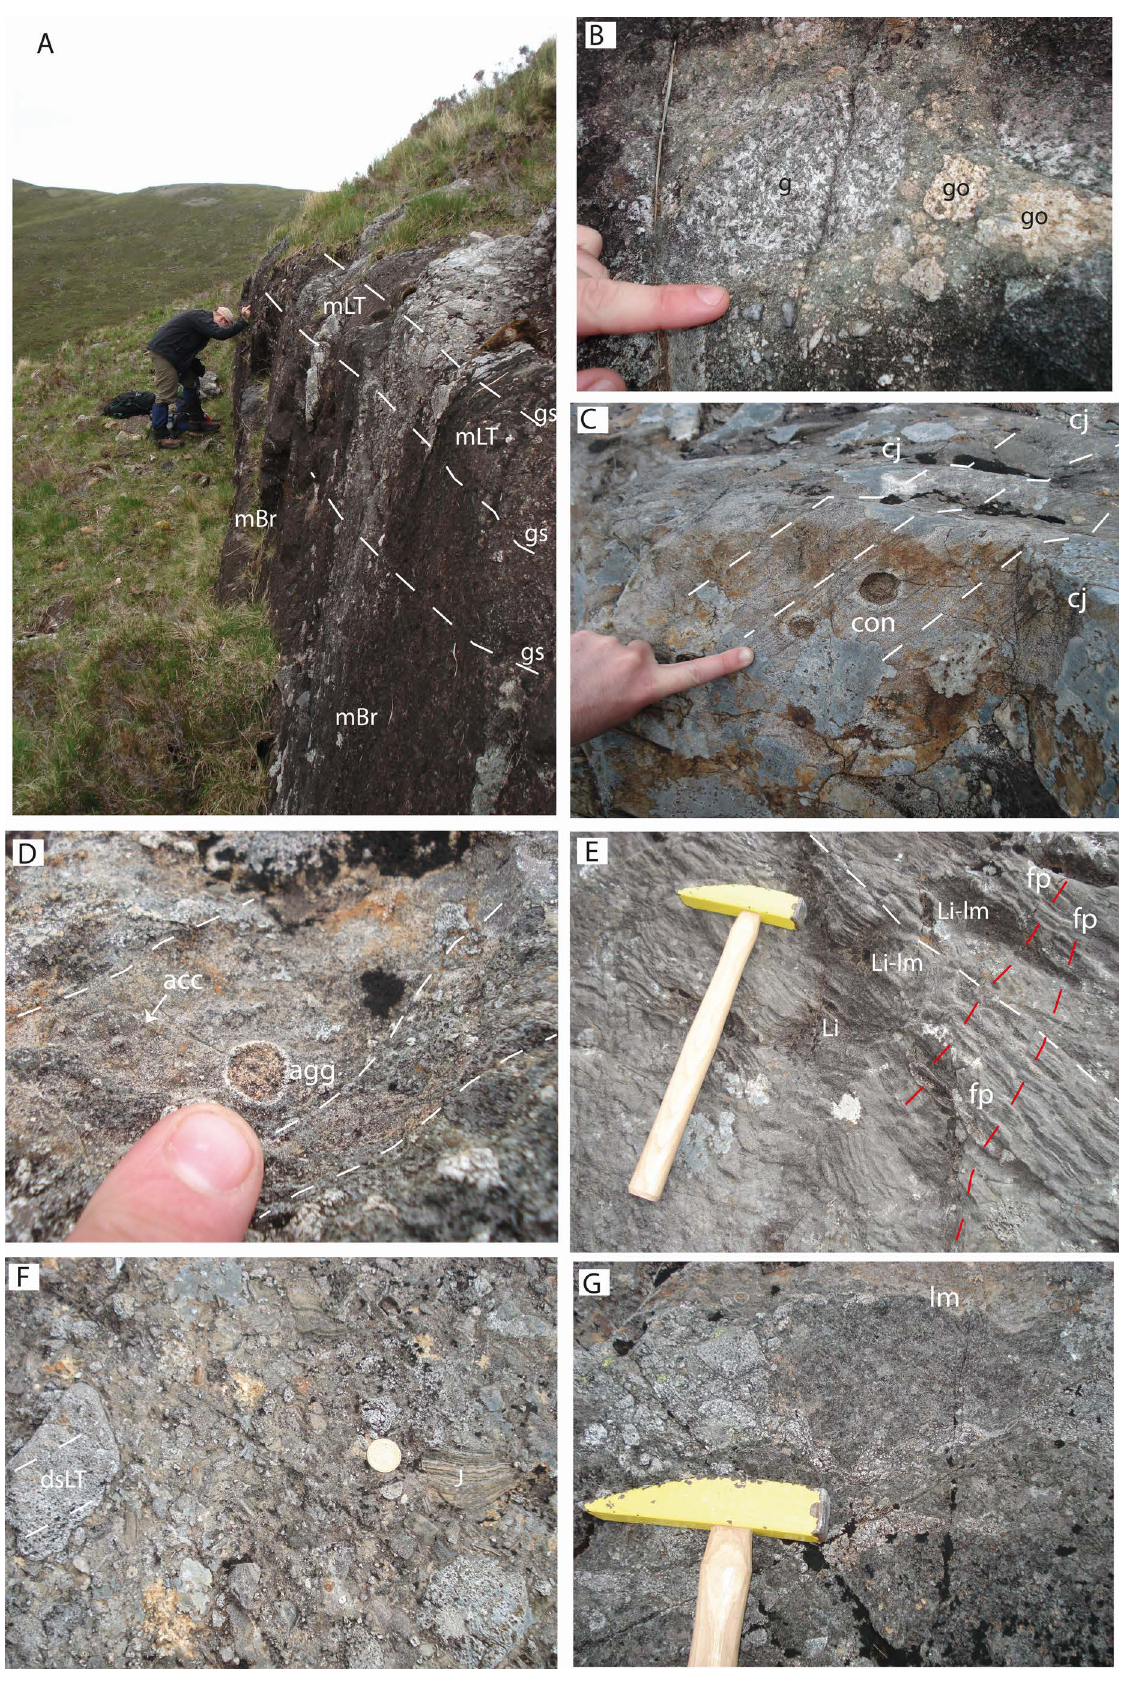
Figure 9: (Caption next